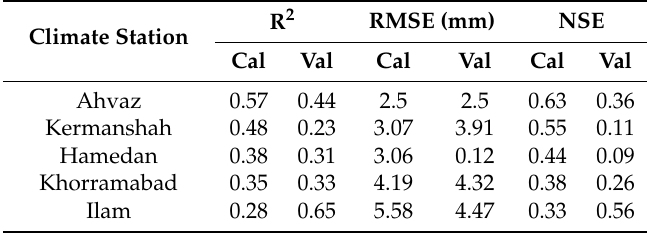
Table 2. Coefficient of determination (R 2 ), root-mean-square error (RMSE) and Nash–Sutcliffe efficiency (NSE) of SM2RAIN model fit of rainfall at the 5 Karkheh river basin (KRB) climate stations for calibration and validation periods.